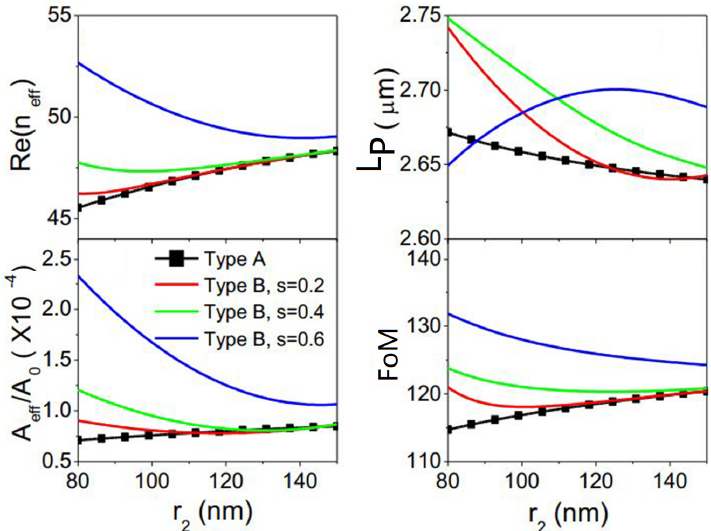
Figure 6. Comparison of the performance of two kinds of waveguides illustrated in Figure 2h,i. Reprinted with permission from reference [75]. Copyright Elsevier, 2019.